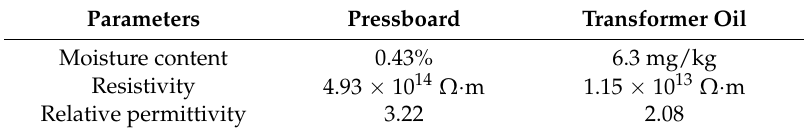
Table 1. Dielectric parameters and moisture content of pressboard and transformer